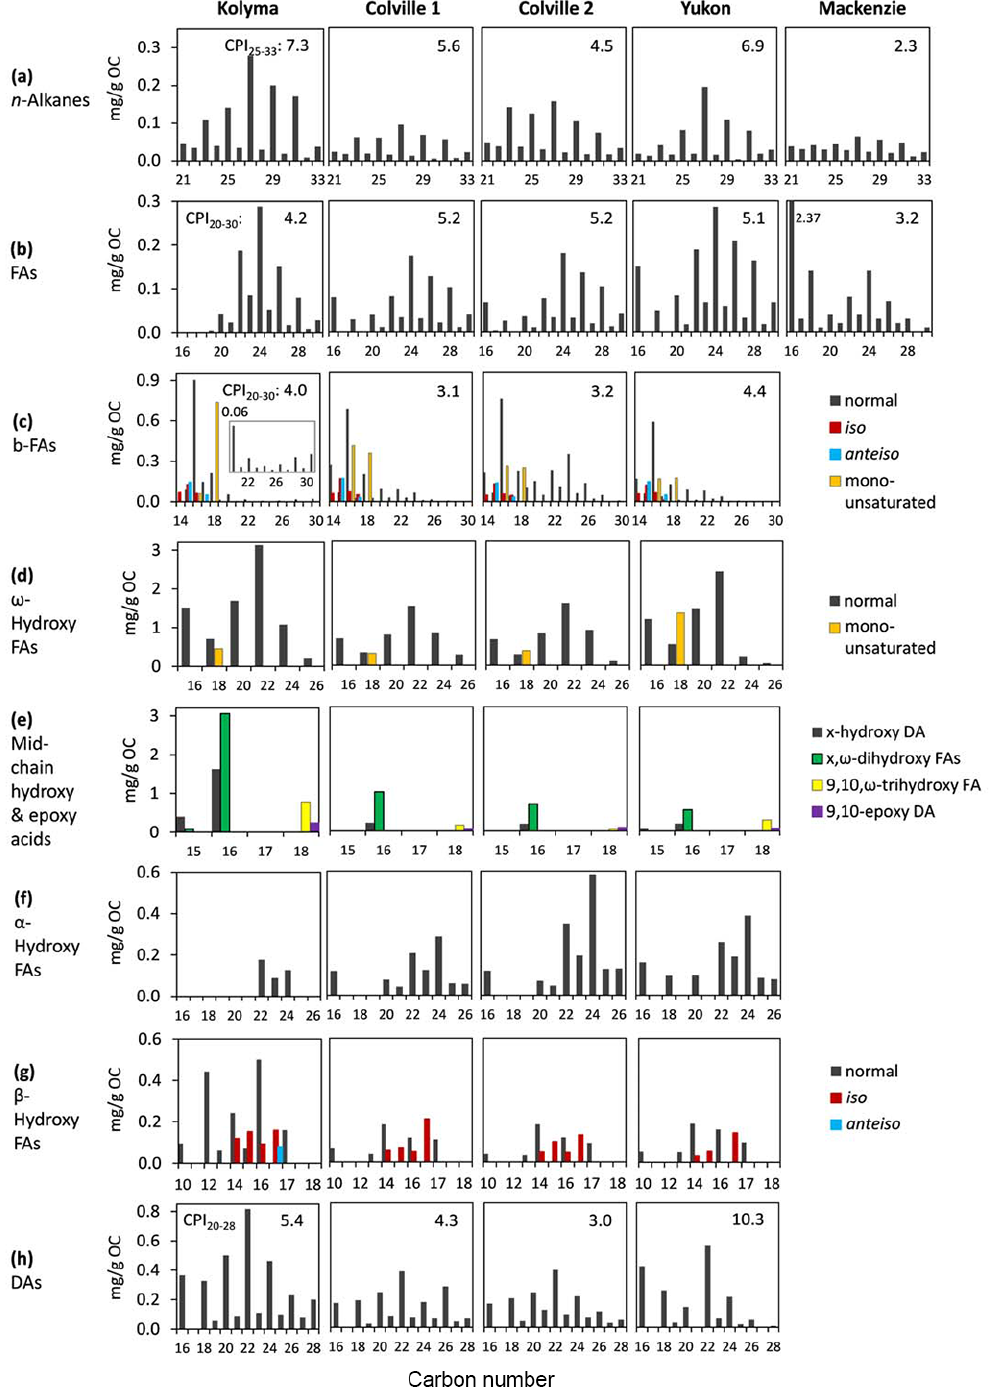
Figure 2. Abundances of solvent-extractable and hydrolyzable lipids in the pan-Arctic sedimentary particles, includ- ing n -alkanes (a) , fatty acids (FAs; b ), bound fatty acids (b-FAs; c ), ω -hydroxy FAs (d) , mid-chain hydroxy and epoxy acids (e) , α -hydroxy FAs (f) , β -hydroxy FAs (g) , and diacids (DAs; h ). Carbon preference index (CPI) is defined as CPI 25 − 33 = ( P C 25 , 27 , 29 , 31 , 33 / P C 24 , 26 , 28 , 30 , 32 + P C 25 , 27 , 29 , 31 , 33 / P C 26 , 28 , 30 , 32 , 34 ) / 2 for n -alkanes, CPI 20 − 30 = ( P C 20 , 22 , 24 , 26 , 28 , 30 / P C 19 , 21 , 23 , 25 , 27 , 29 + P C 20 , 22 , 24 , 26 , 28 , 30 / P C 21 , 23 , 25 , 27 , 29 , 31 )/ 2 for FAs and b-FAs, CPI 20 − 28 = ( P C 20 , 22 , 24 , 26 , 28 / P C 19 , 21 , 23 , 25 , 27 + P C 20 , 22 , 24 , 26 , 28 / P C 21 , 23 , 25 , 27 , 29 )/ 2 for DAs. Data of solvent-extractable n -alkanes and FAs are derived from van Dongen et al. (2008a) for GRARs, Vonk et al. (2008) for Kalix, and Drenzek et al. (2007) for